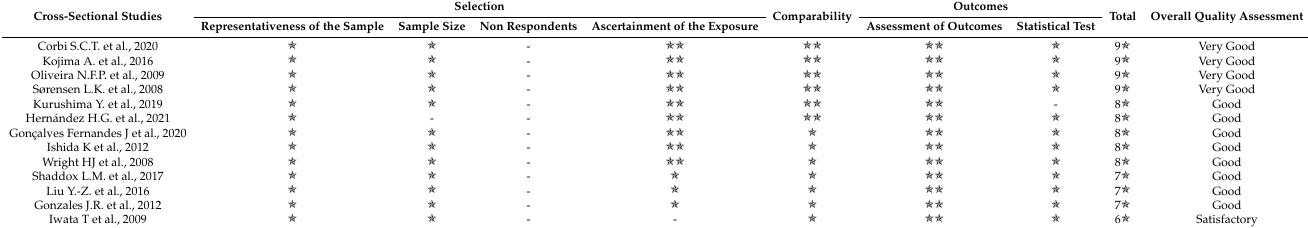
SørensenL.K.etal.,2008